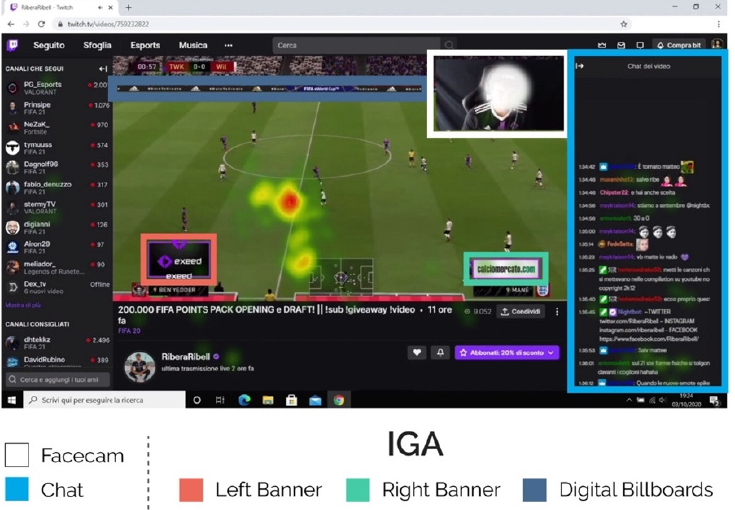
Figure A1. Areas of interest (AOIs) selected for the study. Note: The heat maps shown in the figure were not visible to the participants and were produced in the analysis phase.